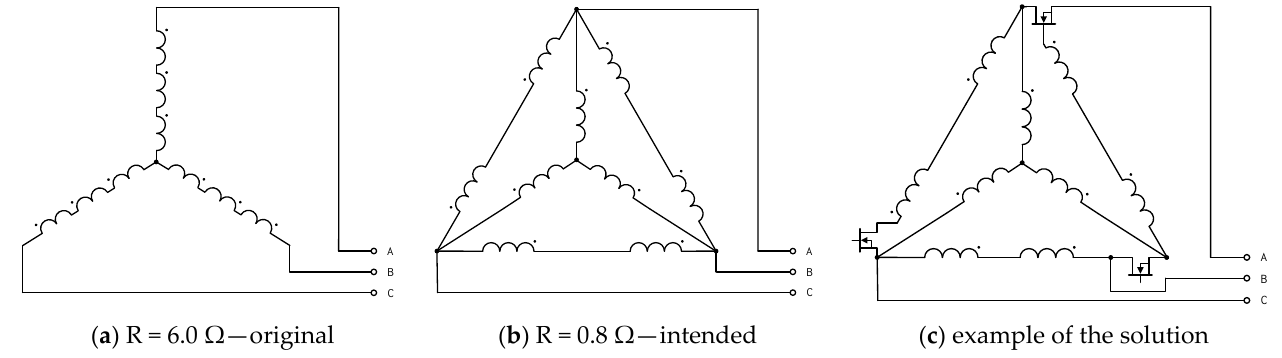
Figure 7. Modification example of the inner winding configuration using 3 FETs.